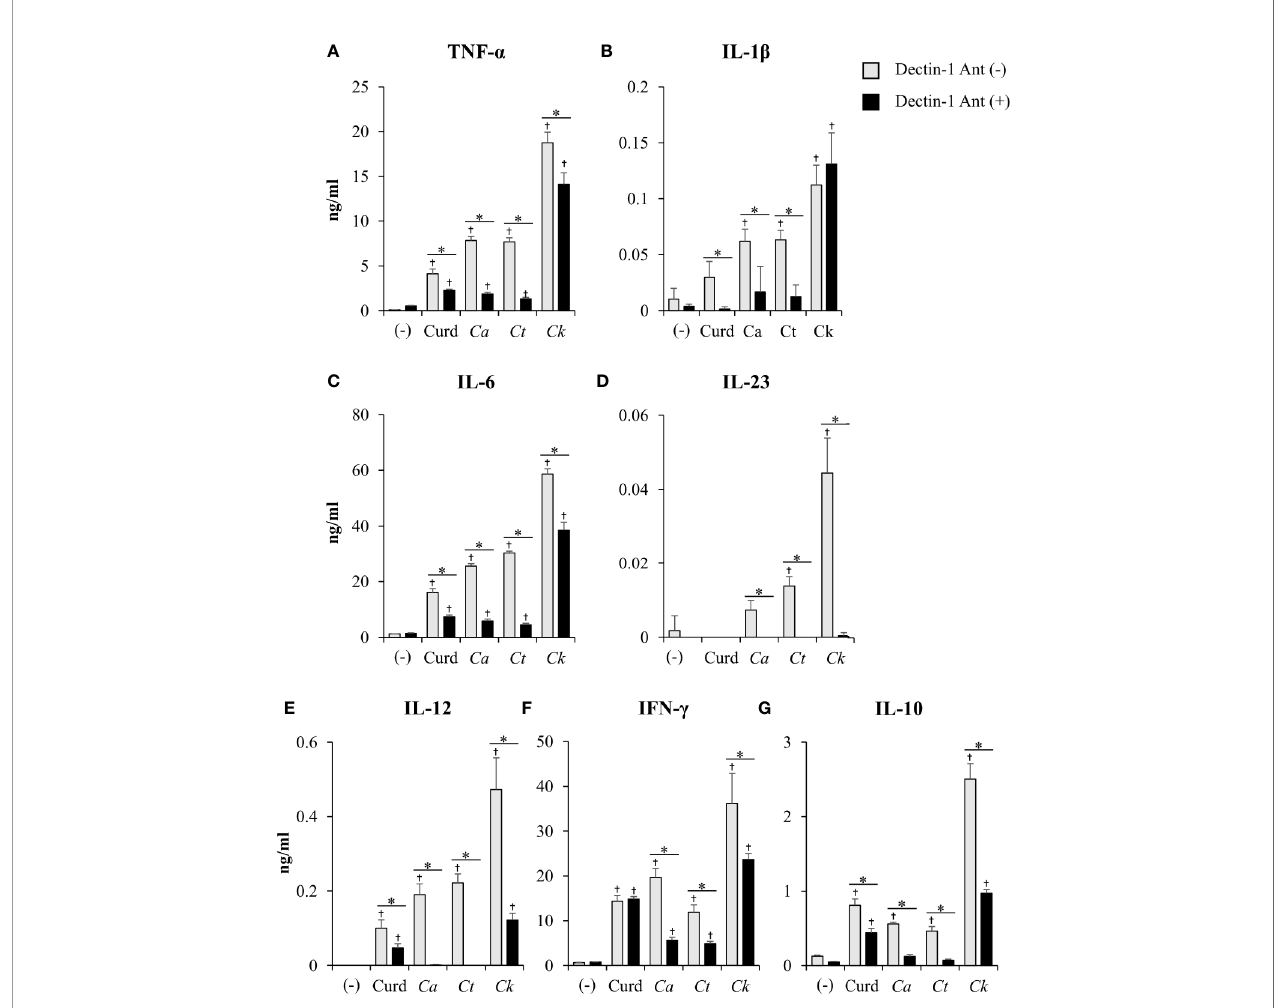
FIGURE 10 | Contribution of dectin-1 blockade to dendritic cell (DC) cytokine production. Bone-marrow derived DCs (BMDCs) were pre-treated with 25 µg/ml of dectin-1 antagonist for 2 h, and then the cells were stimulated with 25 µg/ml of curdlan and b -glucans isolated from C. albicans , C. tropicalis , and C. krusei for 24 h. Levels of (A) TNF- a , (B) IL-1 b , (C) IL-6, (D) IL-23, (E) IL-12, (F) IFN- g , and (G) IL-10 were measured in culture supernatants by ELISA. n = 5; data are representative of two independent experiments. † p <0.05 compared with unstimulated BMDCs, * p <0.05. (-), unstimulated BMDCs; Curd, curdlan; Ca , C. albicans ; Ct , C. tropicalis ; Ck , C. krusei